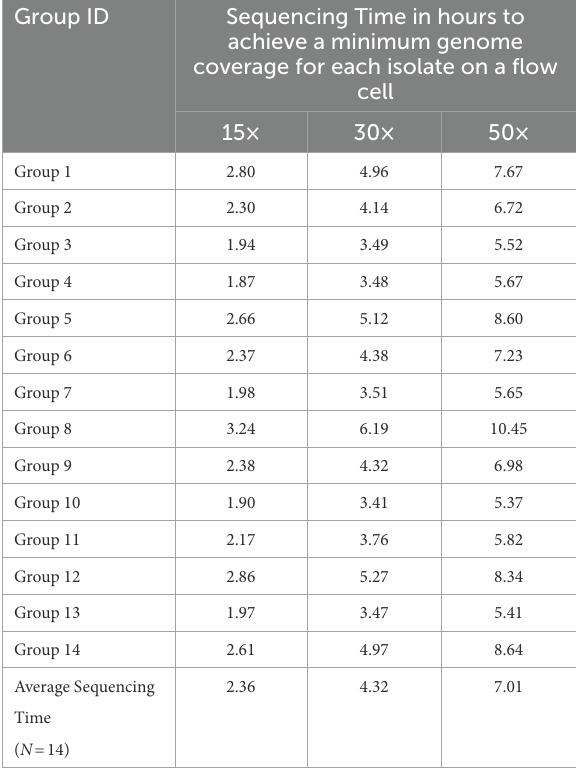
TABLE 5 ONT multiplex sequencing time per flow